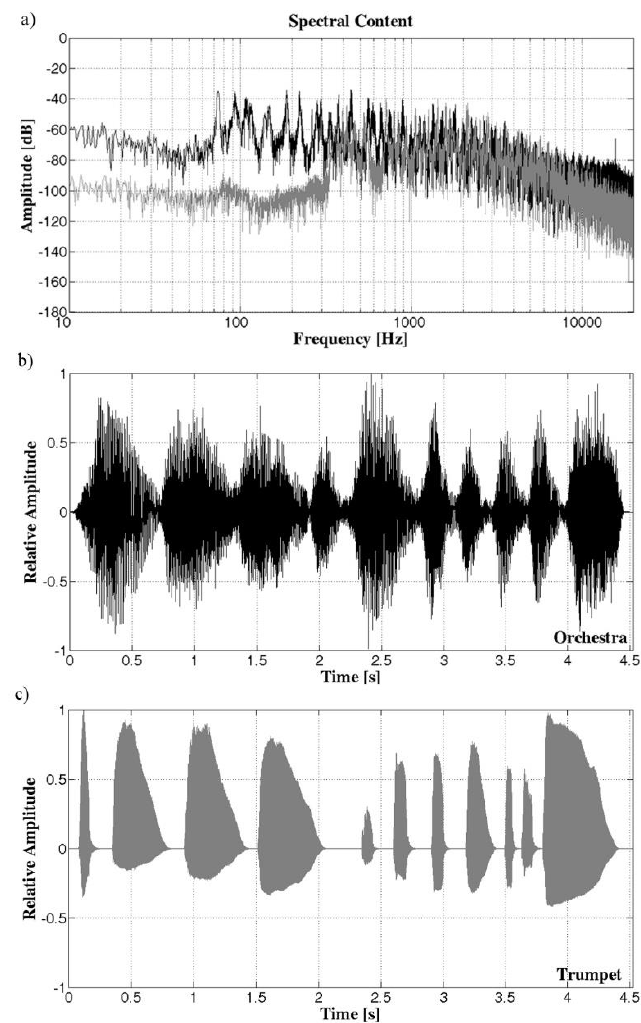
Figure 4. Orchestra and trumpet anechoic stimuli: ( a ) spectral content, ( b ) waveform of the orchestra sample, and ( c ) waveform of the trumpet sample.